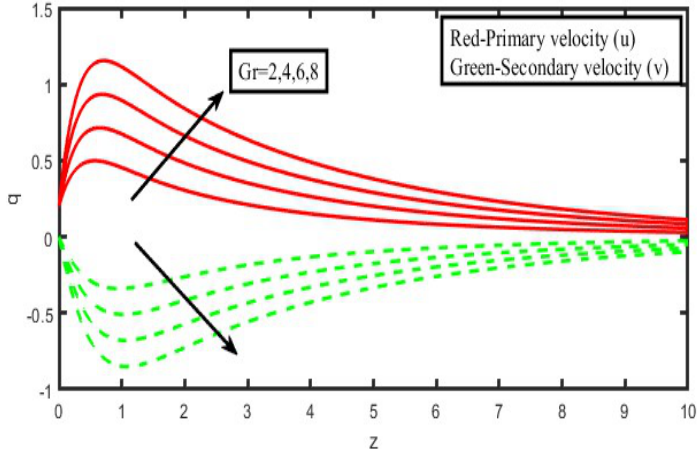
Figure 2. Velocity profiles for u and v for thermal Grashof number (Gr).